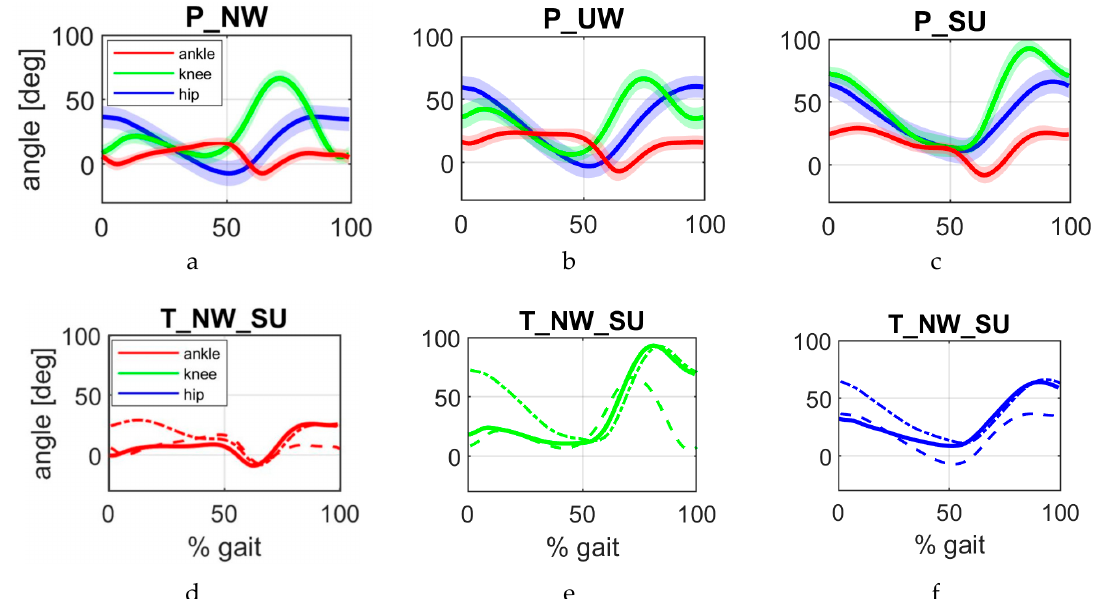
Figure 3. Ankle (red), knee (green) and hip (blue) flexion angles over a gait cycle (solid line: mean; shaded area: mean ± 1 SD). See Table 1 to interpret the trial code. ( a – c ) Examples of periodic gait tasks. ( d – f ) Single joint analysis of the transient T_NW_SU (solid line: mean; dashed line: starting periodic task; dash-dot line: ending periodic gait task). ( d ) Ankle. ( e ) Knee. ( f ) Hip.